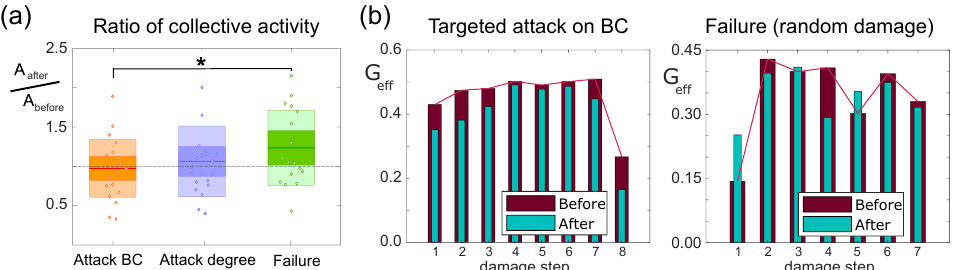
Figure 3. Damage on aggregated cultures. ( a ) Box plot of the collective activity ratio between after ( A after ) and before ( A before ) damage for the three different kinds of attack. The dots in each box plot include three experimental repetitions and different damage steps on the same culture. Statistically significant differences are only observed between targeted attack on BC and failure (* p = 0.0191, Student’s t -test). ( b ) Bar plots representing the evolution of the global efficiency G eff along a full sequence of damage for a pair of representative experiments, and considering targeted attack on nodes with the highest betweenness centrality (left) and failure (right). For each damage step, the pairs of bars compare the G eff values before and after the deletion of an